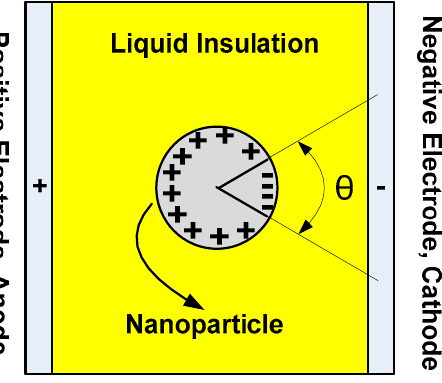
Figure 16. Simulated nanoparticle with mixed charges in liquid dielectric.